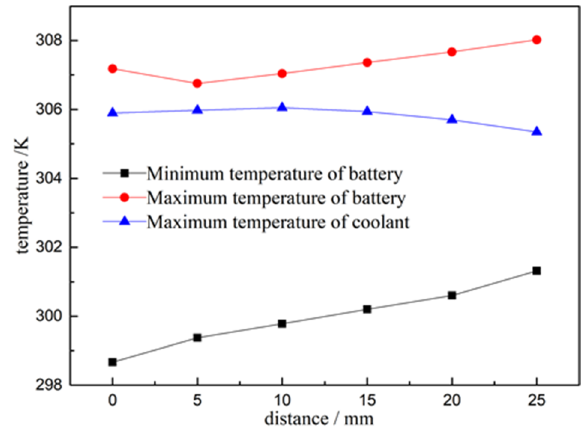
Figure 7. Temperatures for different distances between the cooling pipe and terminal.